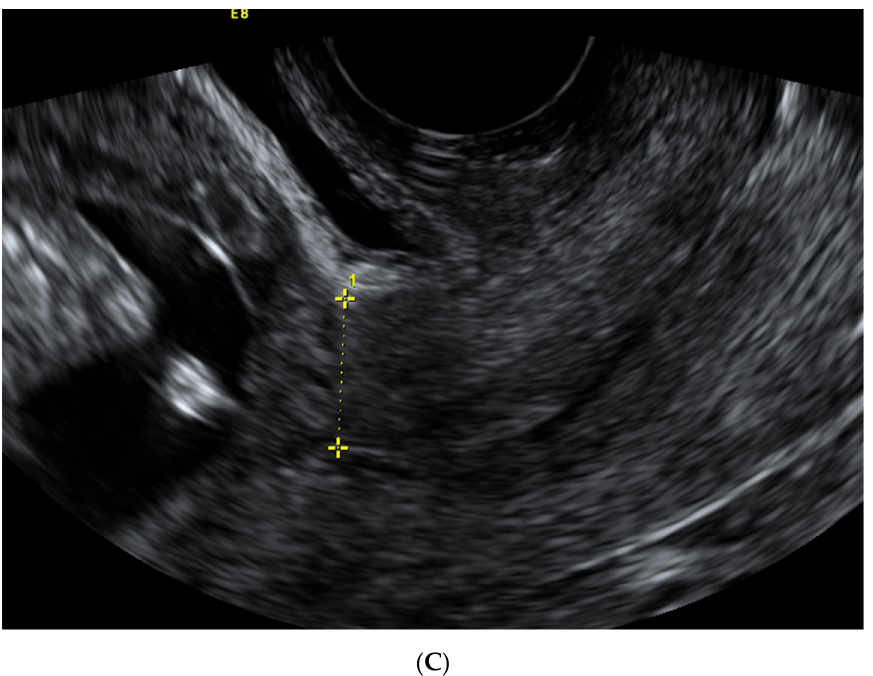
Figure 2. First-trimester ultrasound images of a CS scar niche ( A ), a visible CS scar ( B ) and a non-visible CS scar ( C ).